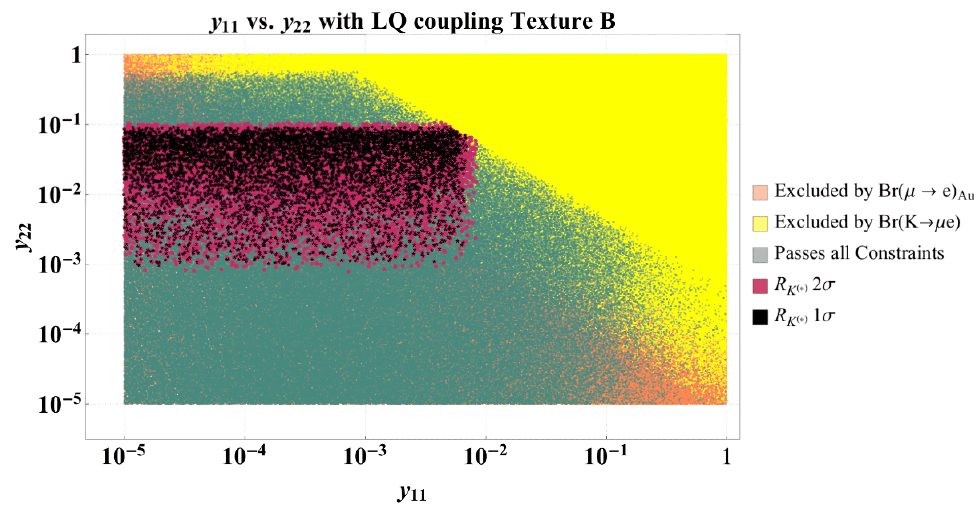
Figure 17 . Indicative plot of the allowed parameter space in the y 22 vs. y 11 plane, for leptoquark coupling matrix Texture B. The yellow section is ruled out by Br( K ! (cid:22)e ), the orange section is ruled out by Br( (cid:22) ! e ) Au , while the teal region is allowed parameter space; speci(cid:12)cally it passes all constraints discussed in section 3 as well as perturbativity constraints on the diquark coupling constants z LL 1 ij